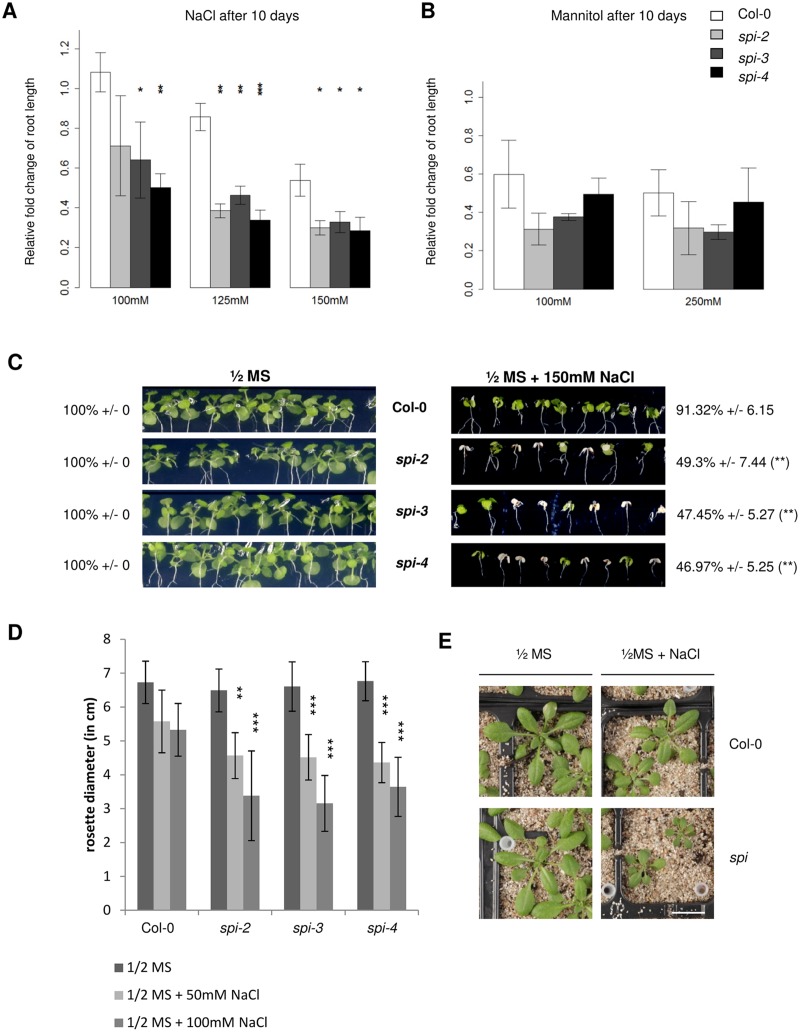

spi mutants display salt hypersensitivity.Relative changes of root length after 10 d on ½MS plates supplemented with (A) 100 mM, 125 mM, and 150 mM NaCl or (B) 100 mM and 250 mM Mannitol (Man). Data in (A) and (B) were normalized to nonstress conditions and denote the average from three independent biological replicates (n = 12 seedlings each). Error bars represent standard deviations. Two-tailed student’s t tests were performed to compare spi alleles and Col-0 exposed to the same conditions (* p < 0.05; ** p < 0.01; *** p < 0.001). (C) Cotyledon greening of seedlings measured after 14 d on ½MS plates supplemented with 150 mM NaCl. Greening efficiencies (in %) denote the average from three independent biological replicates (n = 12 seedlings each). Errors represent standard deviations. Two-tailed student’s t tests were performed to compare spi alleles and Col-0 exposed to the same conditions (* p < 0.05; ** p < 0.01; *** p < 0.001). (D) Diameter of leaf rosettes (in cm) of 32-day-old plants, measured after irrigation with ½MS only (control) or ½MS supplemented with increasing NaCl concentrations on every second day (two times ½MS + 50 mM NaCl and two times ½MS +100 mM NaCl). Data denote the average from three biological replicates (n = 14 plants each). Error bars represent standard deviations. Two-tailed student’s t tests were performed to compare spi alleles and Col-0 exposed to the same conditions (* p < 0.05; ** p < 0.01; *** p < 0.001). (E) Representative images of 30-d-old Col-0 and spi-2 plants grown under nonstress (½MS) and salt stress conditions (irrigation two times with ½MS + 50 mM NaCl and one time with ½MS + 100 mM NaCl in alternation with ½MS every second day) on a sand–soil mixture. Scale bar: 1.5 cm.